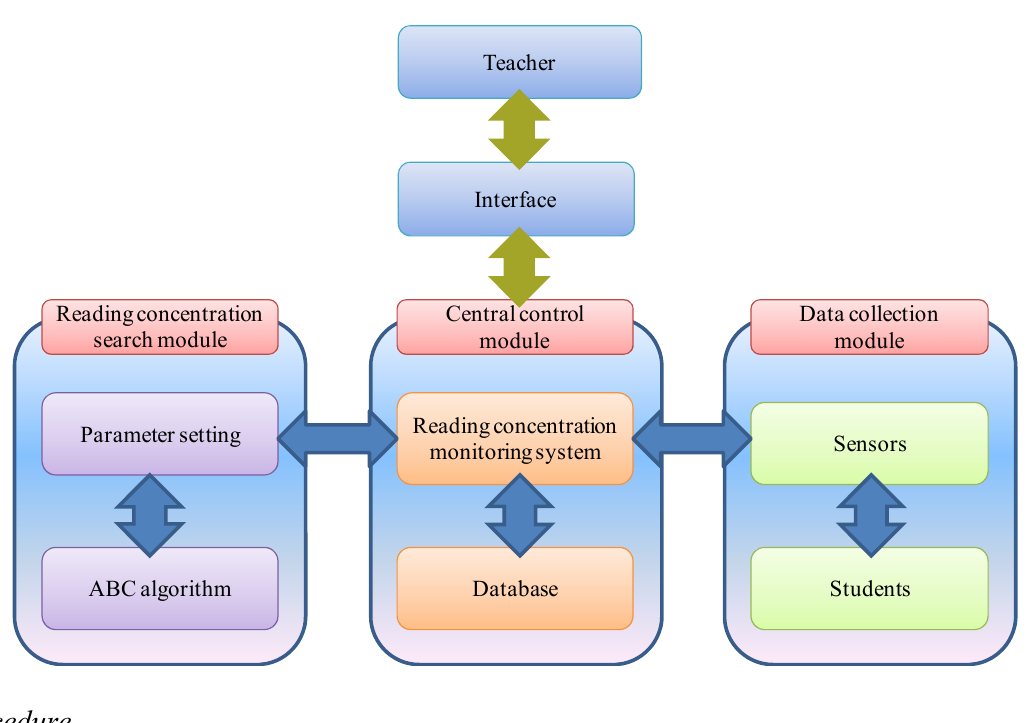
Figure 2. Framework of the reading concentration monitoring